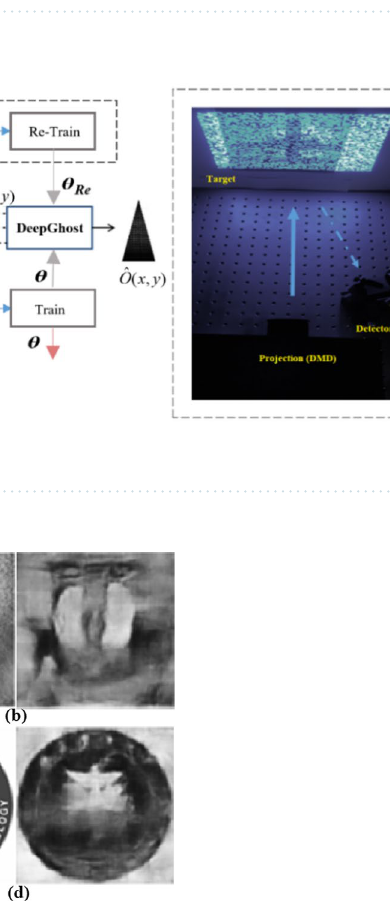
Figure 6. Simulation based image reconstruction using DeepGhost for different sampling ratios.